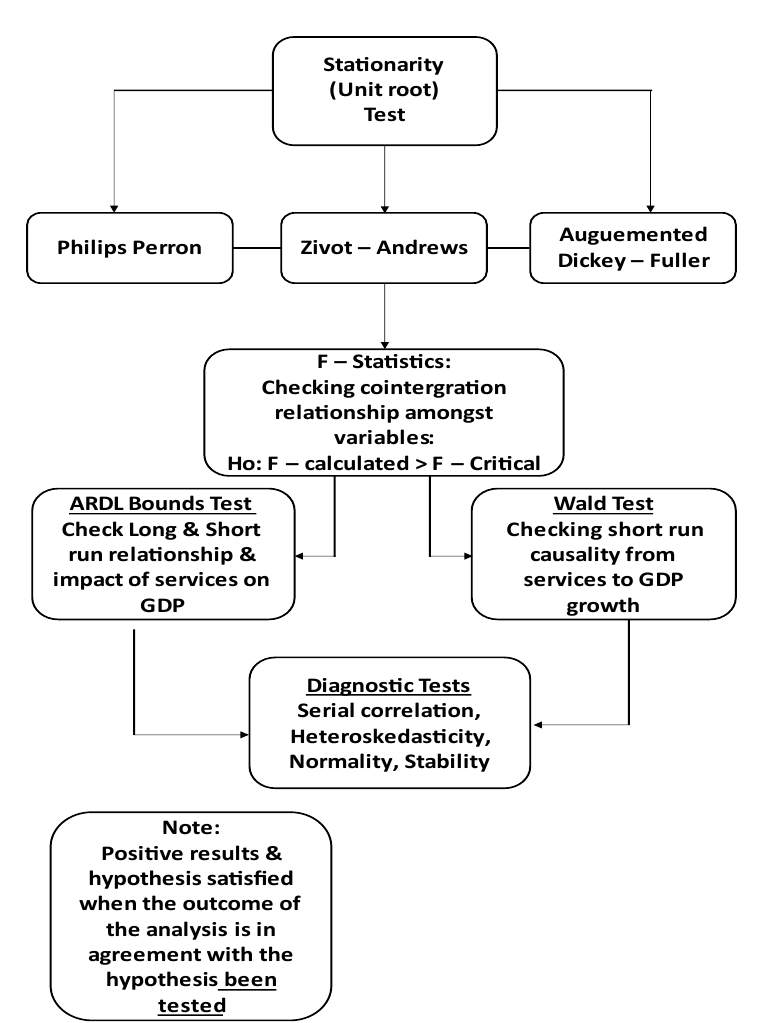
Figure 3. Theory and methodological flow chart.